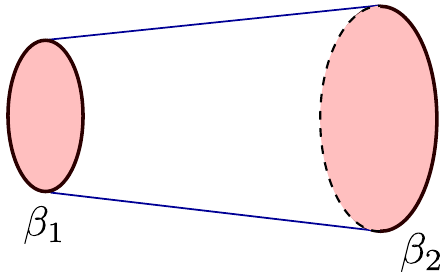
Figure 5. The schematic picture of the black hole phase in the Euclidean signature. The spacetime is two hyperbolic disks connected by the conical